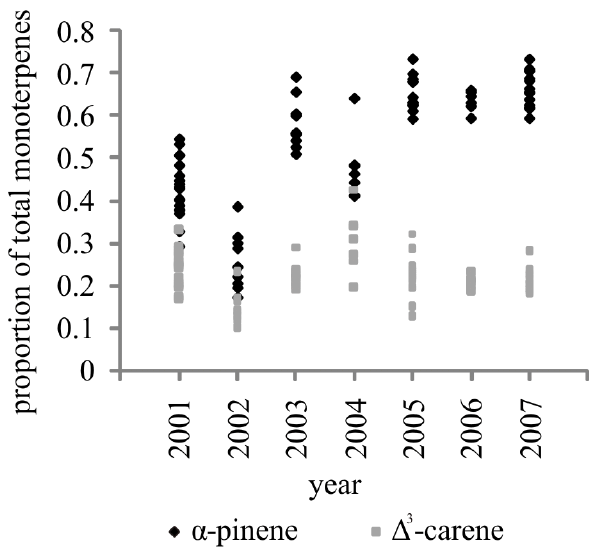
Fig. 8. Summertime (July–August) proportion of α -pinene and 1 3 - carene from total monoterpenes in the air at SMEAR II between years